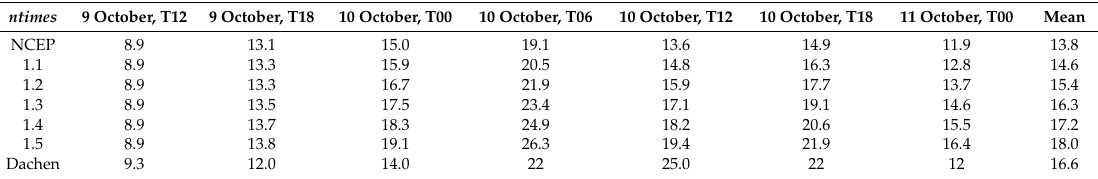
Figure 7. Comparison between the modified and NCEP wind field at 06:00, 10 October. Table 5. NCEP, modified ( ntimes = 1.1 to 1.5) and observed wind speed (m/s) at Dachen from 12:00 9 October to 00:00 11 October. ntimes 9 October, T12 9 October, T18 10 October, T00